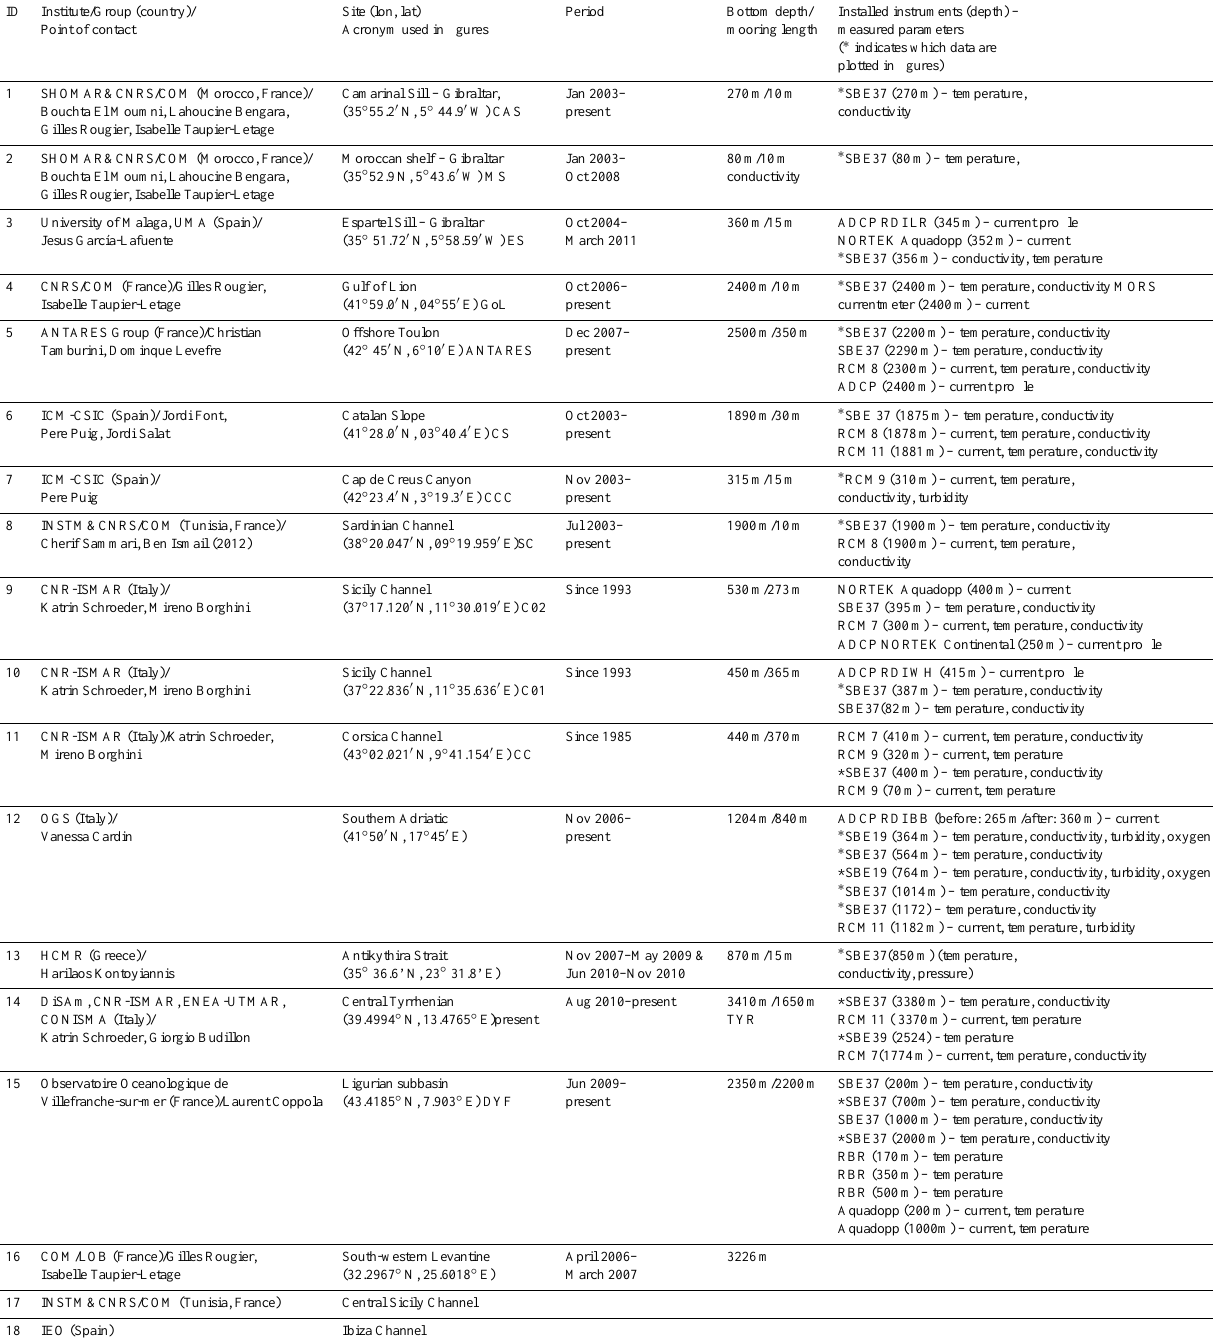
Table 2. Contributing institutes and details of the monitored